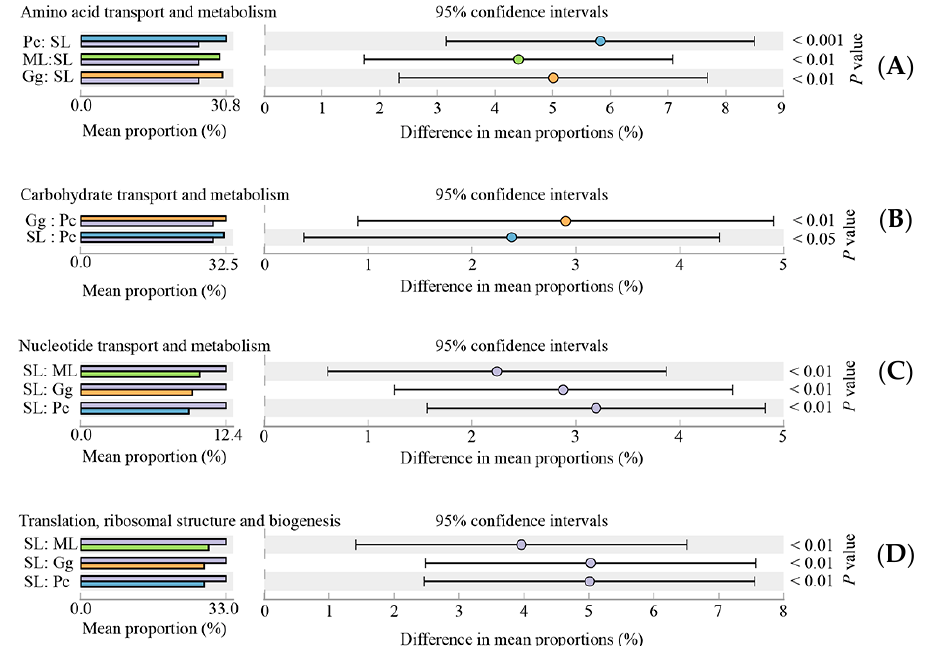
Figure 8. Significant differences ( p < 0.05) in the abundance of operational taxonomic units (OTUs) mapped to predicted Clusters of Orthologous Genes (COG) functional categories amino acid trans- port and metabolism ( A ), carbohydrate transport and metabolism ( B ), nucleotide transport and metabolism ( C ), and translation, ribosomal structure, and biogenesis ( D ). ML: maize leaves; Gg: goosegrass; SL: soybean leaves; Pc: pakchoi.